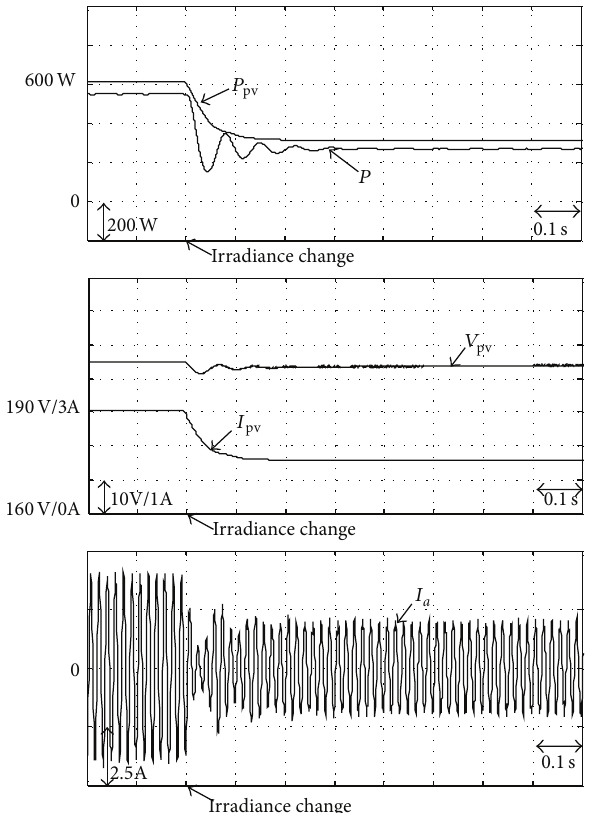
Figure 5: Experimental results of irradiance abrupt change using 2D-RFCMANN